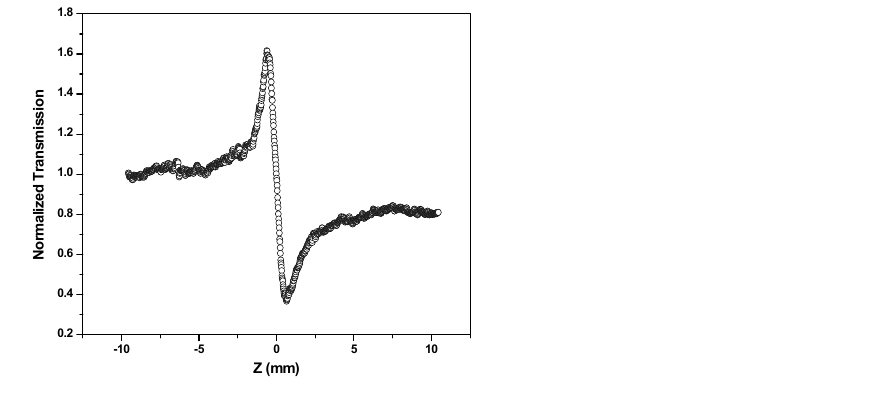
Table 1. Absorption ( α ), nonlinear refractive index ( n 2 ), and nonlinear absorption ( β ) values for colloidal silver nanoparticles. Wavelength, λ (nm)